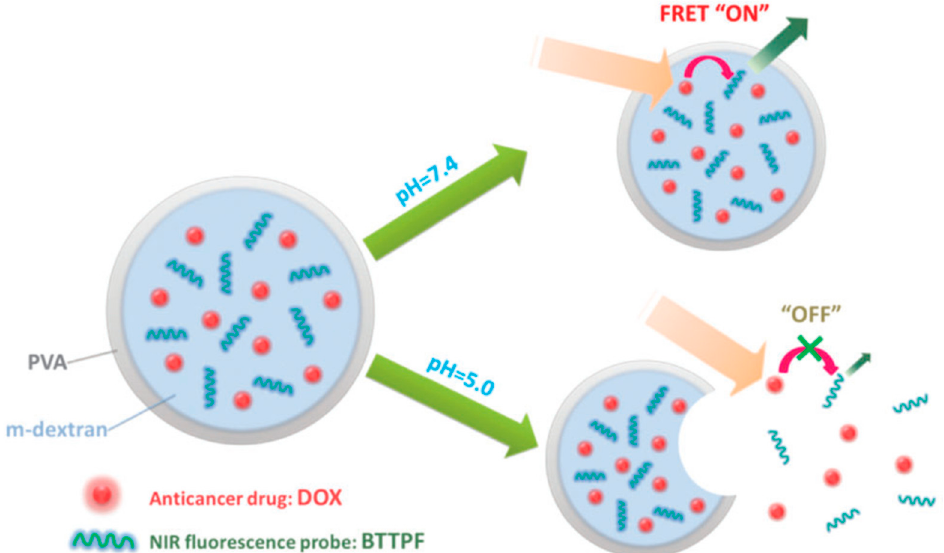
Figure 13. pH-responsive and NIR-emissive polymer NPs as carriers for anticancer drug DOX: fluorescence signal difference under mildly acidic or physiological conditions. Reproduced with permission from ref. [45]. Copyright 2014, The Royal Society of Chemistry.